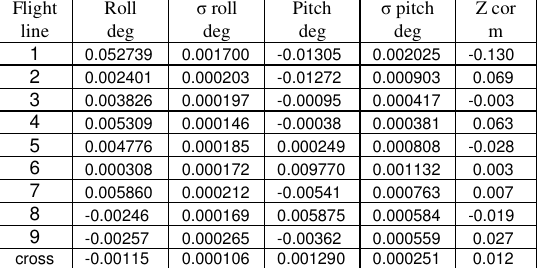
Table 3. Roll, pitch and vertical shift estimates per flight